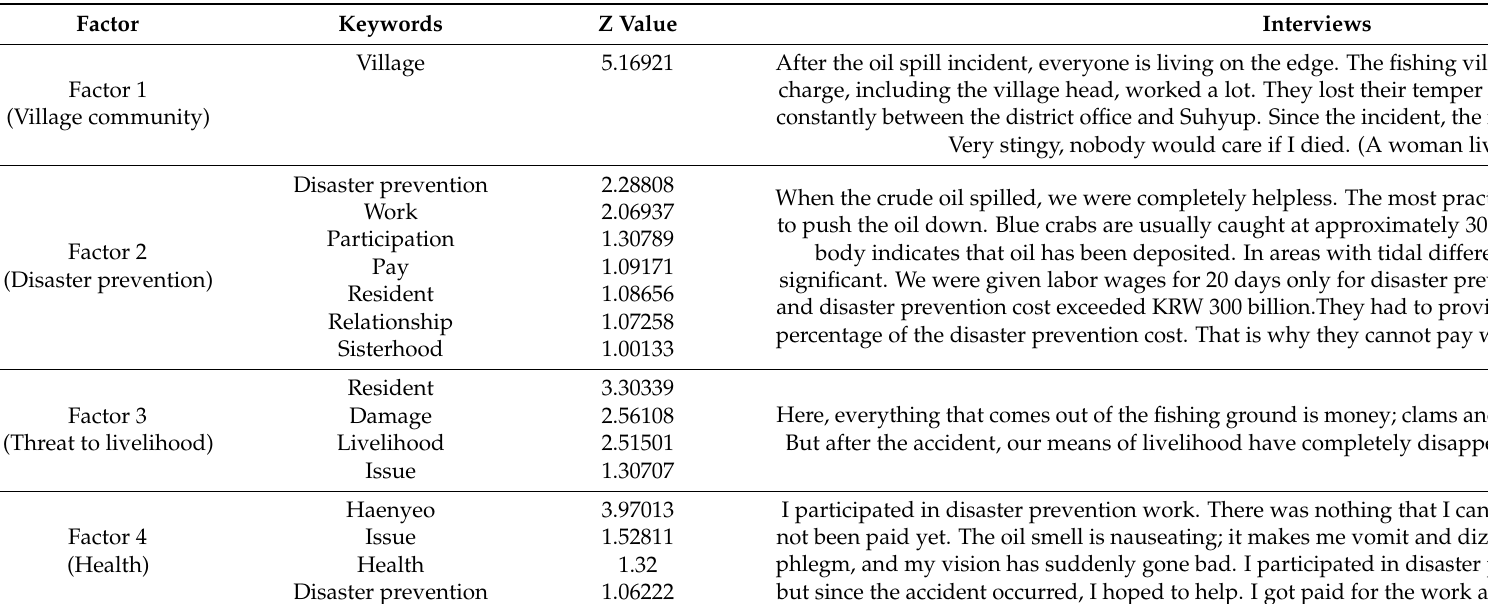
Table 4. Main keywords of each